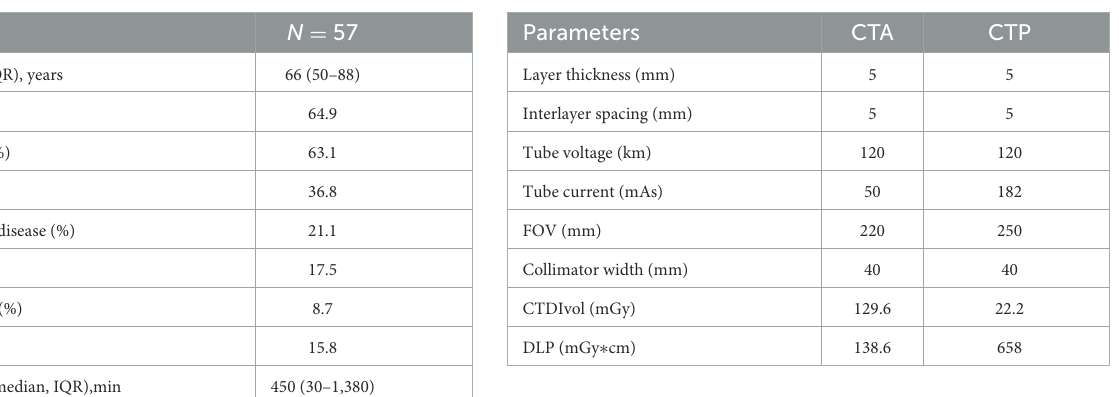
TABLE 3 The diagnostic efficacy of the spectral parameters for ischaemic